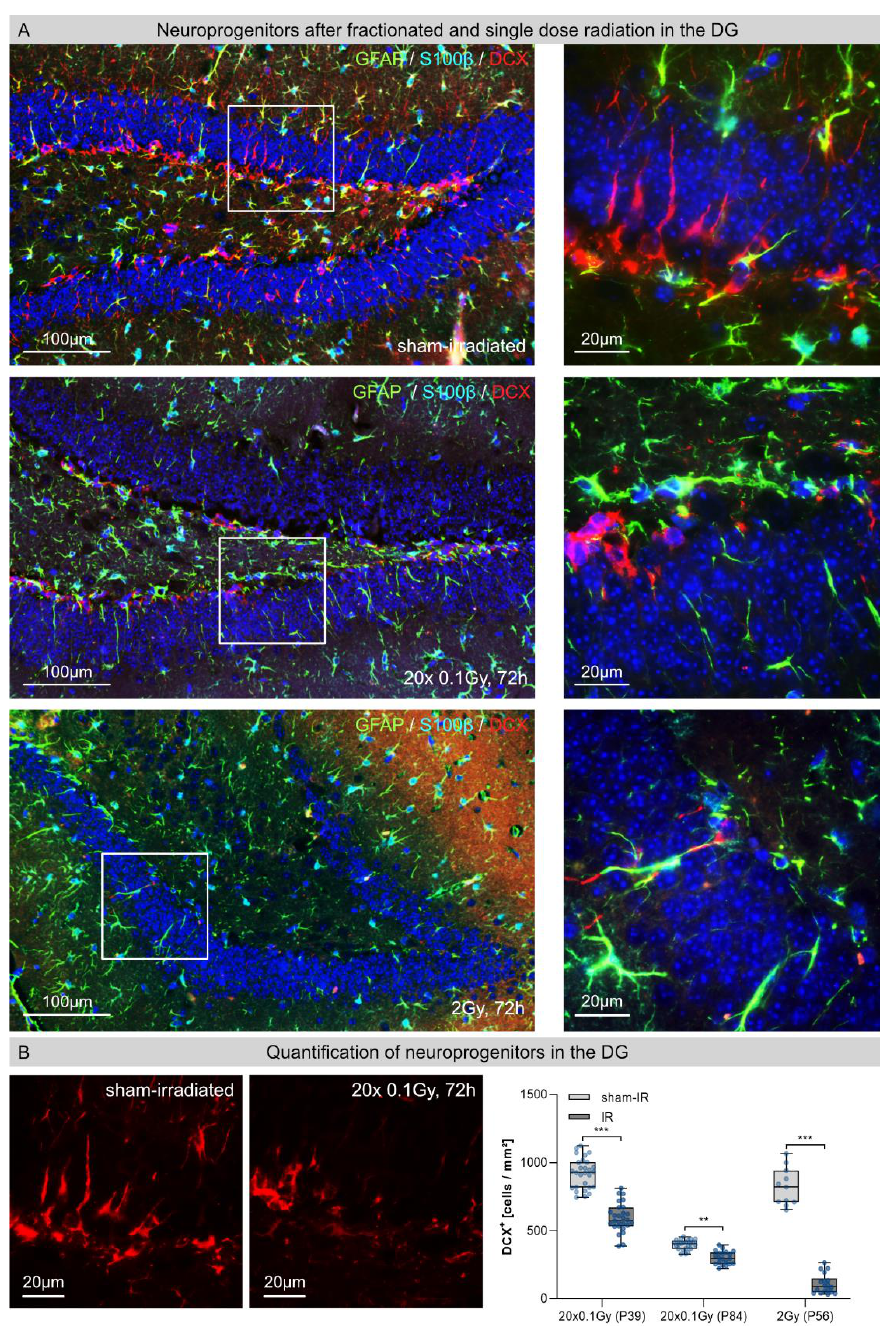
Figure 4. Neuroprogenitors in the hippocampal dentate gyrus (DG) after fractionated low-dose and single-dose radiation. ( A ): Immunofluorescence micrographs of GFAP+ (green)/S100 β + (light-blue) astrocytes and DCX+ (red) neuroprogenitors in the DG of sham-irradiated (upper panel), fractionated low-dose irradiated (20 × 0.1 Gy, 72 h post-IR; middle panel) and single-dose irradiated (1 × 2 Gy, 72 h post-IR; lower panel) brains. Framed regions are shown at higher magnifications. Insets: following FLDR, neuroprogenitors showed dramatically impaired dendritic arborization; following SDR, neuroprogenitor populations in the SGZ were drastically reduced. Original magnification: 600x. ( B ): In the DG of juvenile and adult mice, the numbers of DCX+ neuroprogenitors were quantified after 20 × 0.1 Gy versus 1 × 2 Gy (72 h post-IR), in comparison to age-matched, sham-irradiated controls. Error bars represent SEM, n ≥ 3; * denotes statistically significant difference compared to sham-irradiated control: ** p < 0.01, *** p < 0.001.